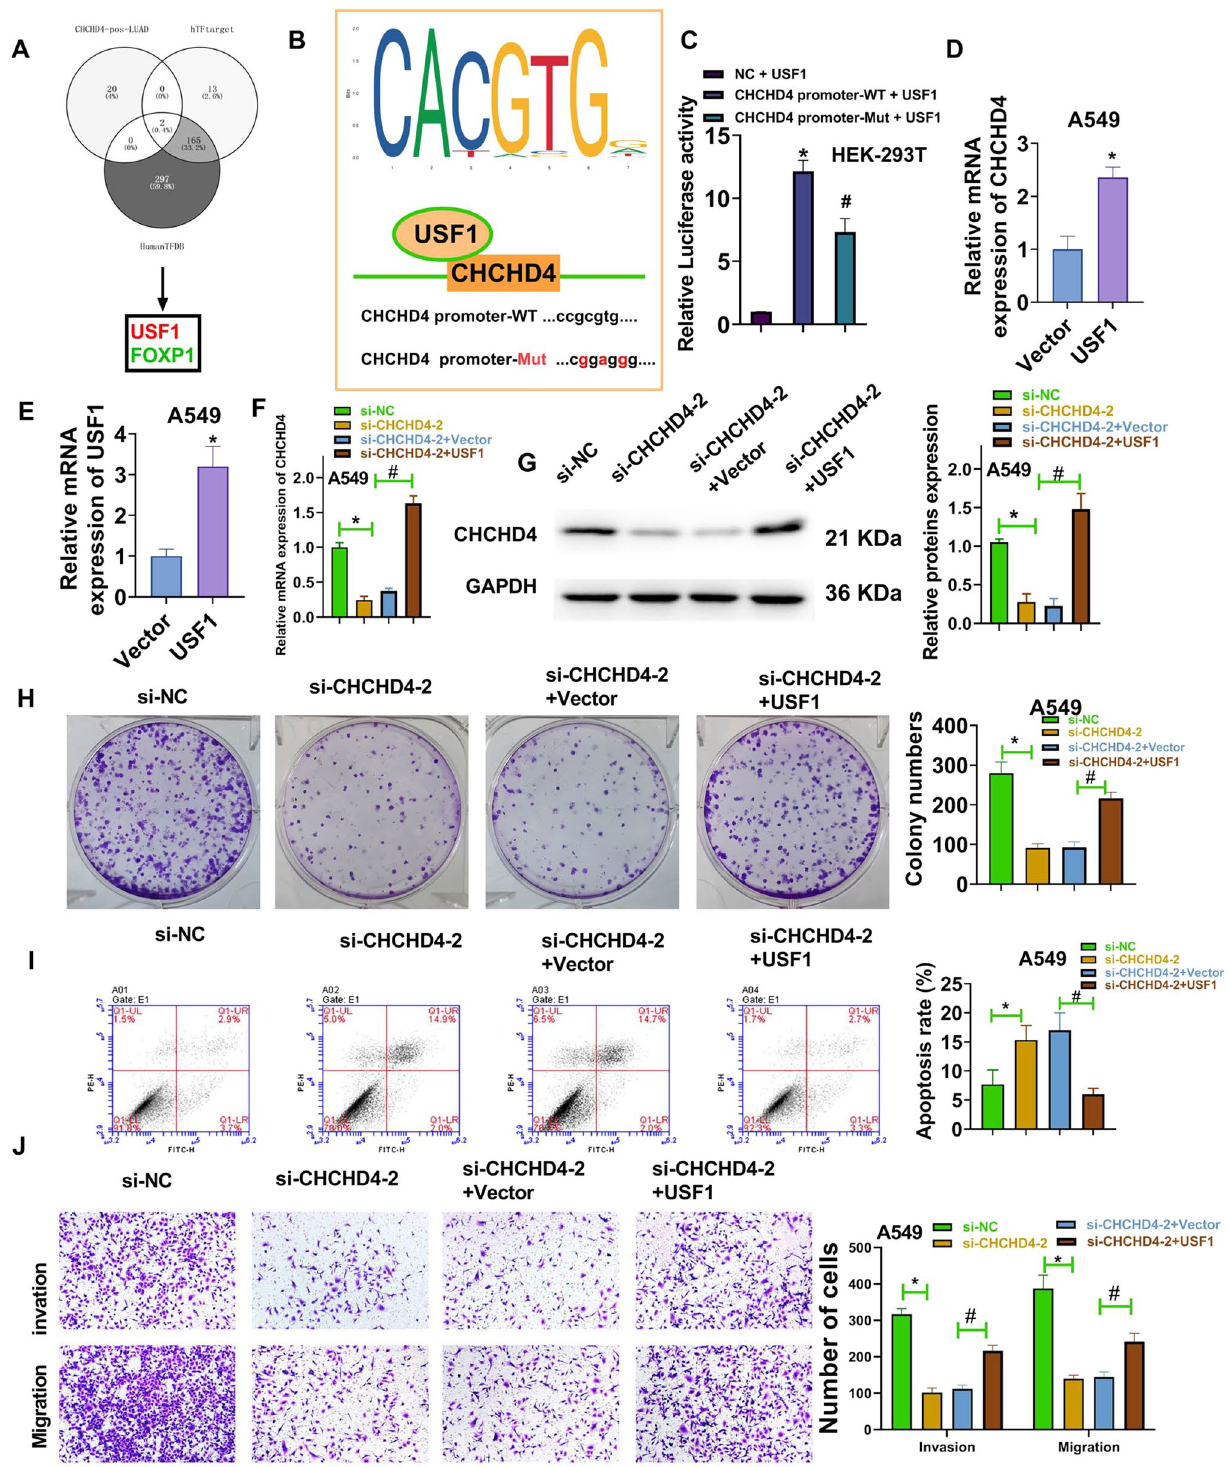
Fig. 4 USF1 upregulated CHCHD4 and promoted the progression of LUAD. A Venn chart identified 2 genes ( USF1 and FOXP1 ) via analysing the human TFDB, hTFtarget and the genes positively associated with CHCHD4 expression in TCGA-LUAD. B The JASPAR website was used to identify the binding sites of USF1 in the CHCHD4 promoter region. C Luciferase activities were evaluated via performing dual luciferase reporter assay. After pcDNA3.1-USF1 vector was transfected into A549 cells, the mRNA levels of CHCHD4 ( D ) and USF1 ( E ) were determined using qRT-PCR. After pcDNA3.1-USF1 vector and si-CHCHD4-2 were co-transfected into A549 cells, the expression of CHCHD4 was measured using qRT-PCR and western blot ( F – G ); cell colonies were analysed using a colony formation assay ( H ); apoptosis was assessed using FITC- Annexin V/PI apoptosis detection kit ( I ); migration and invasion were tested using a transwell assay ( J ). * P < 0.05, # P <